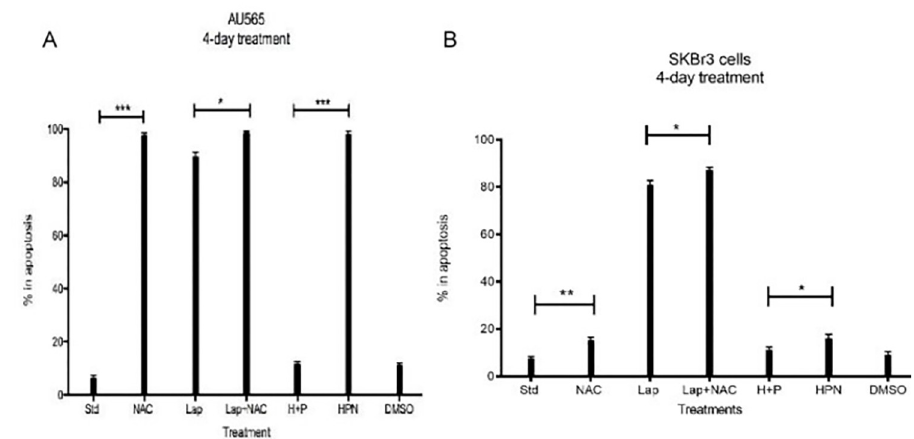
Fig 7. Investigating matriptase-directed 5mM NAC treatment demonstrated increased apoptosis alone or in combination in HER2-amplified breast cancer cells. 100,000 A) AU565 and B) SKBr3 cells were seeded in 6-well plates and allowed to attach overnight. Cells were then treated with 5mM NAC, 5.4 uM Lapatinib and the combination of 10ug/ml Trastuzumab and 10ug/ml Pertuzumab alone or in combination in serum-replete media for four days. NAC was administered again on day 3. Cells were collected and apoptosis determined by Annexin V/Propidium Iodide staining. Graphs are representative of 3 biological replicates. AU565 control ( ��� , p < .001 vs NAC), Lap ( � , p = .0159 vs Lap+NAC), H+P( ��� , p,0.0001), SKBr3 control ( �� , p = .0034 vs NAC), H+P( � , p = .0299 vs HPN, Lap ( � , p = .0134 vs Lap+NAC) ( �� , p = .0034 vs NAC) Lap R Control ( ��� , p = .0003 vs NAC), MTOR ( � , p = .0125 vs